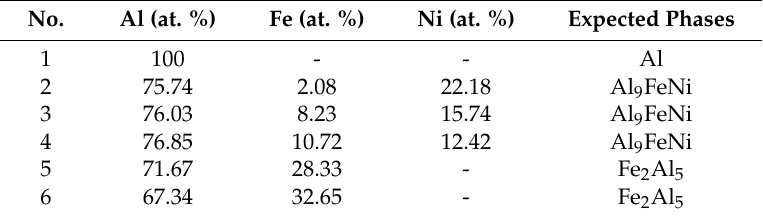
Figure 6. Scanning transmission electron microscopy (STEM) results showing the of focused ion beam (FIB) specimen extracted from the area denoted by X 1 in Figure 5: ( a ) high-angle annular dark-field (HAADF) Image; ( b – f ) results of EDS: ( b ) Al; ( c ) Ni; ( d ) Fe; ( e ) Mn; ( f ) C. Table 2. EDS analysis results and expected phases in the area indicated by 1–4 in Figure 6a.